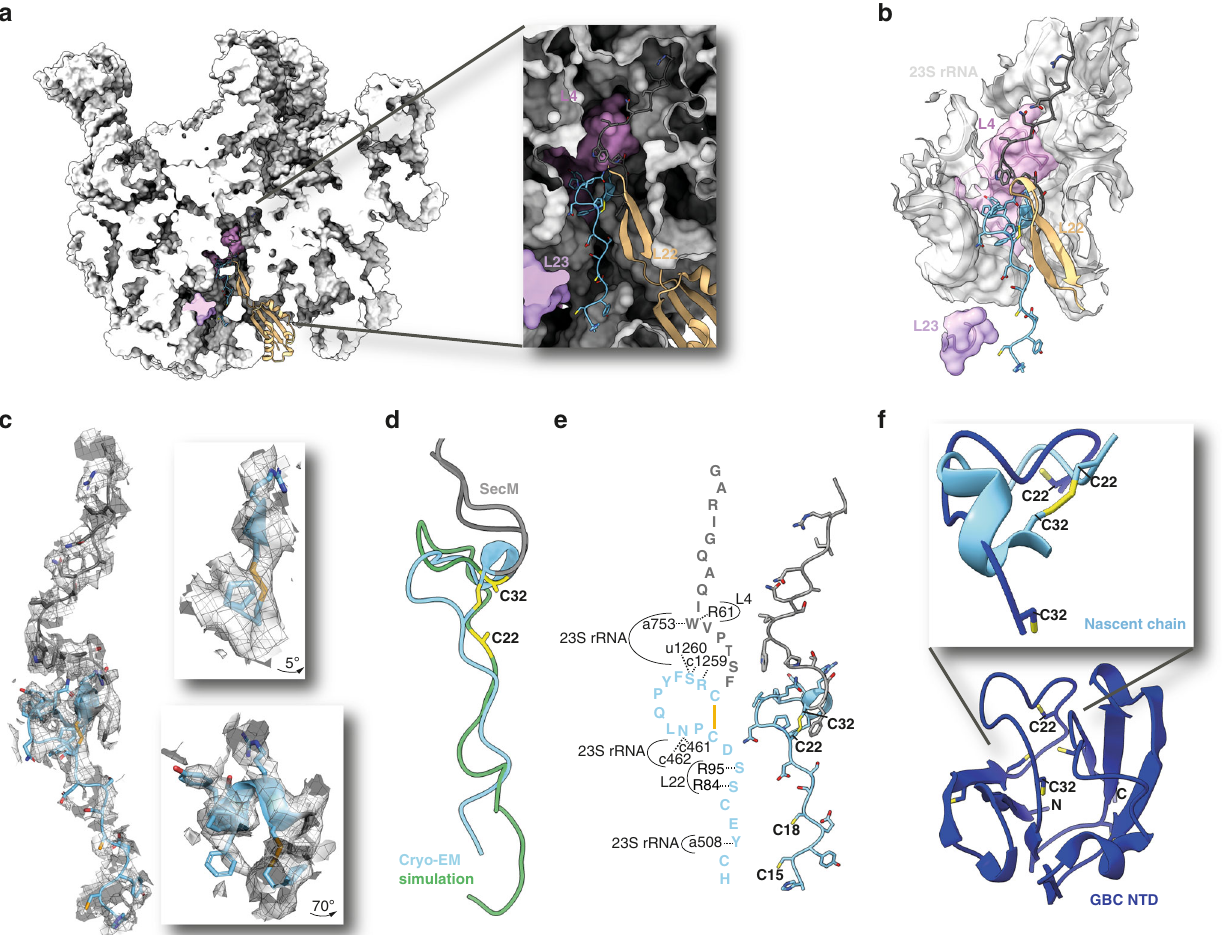
Fig. 3 Cryo-EM structure and structural analysis of U32SecM. a Side view of ribosomal 50S subunit with focus on the nascent chain. The surface of nucleotides 753, 1323 – 1325, and 1616 of the 23S rRNA were hidden to gain a full view on the nascent chain. b U32SecM in the ribosomal exit tunnel with the surrounding area (within 20 Å) shown in surface and cartoon representation. c Cryo-EM density of 2.0 Å around the nascent chain with model of U32SecM and detail view on the α -helix and disul fi de bond. d Overlay of nascent chain model and fl exible-meccano simulation, with possible disul fi de bond between Cys22 and Cys32. RMSD of Cys22 and Cys32 to the cryo-EM structure is 3.72 and 2.98 Å, respectively. e Model of nascent chain with interactions to ribosomal proteins and 23S rRNA represented. Nucleotides and amino acids are shown in lowercase and uppercase one-letter code, respectively. f Overlay of loop between Cys22 and Cys32 of the full-length GBC protein (4W9A) and the nascent chain U32SecM (6YS3). RMSD = 4.33 Å. Cysteine residues are labeled and shown as sticks. The 23S rRNA is shown in light gray, SecM in dark gray, the nascent chain in light blue, L4 in light pink, L22 in light orange, and L23 in